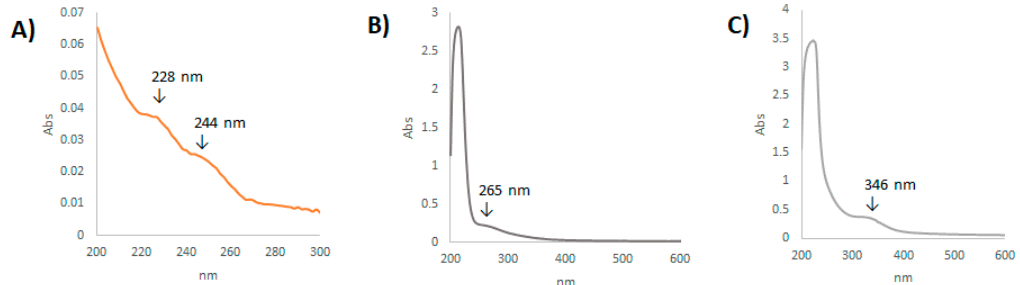
Figure 1. ( A ) Representative Cd UV-Vis spectrum recorded in distilled water. The spectral region 200–300 nm was highlighted; ( B ) Representative Cd UV-Vis spectrum acquired in tank water; ( C ) Cd + TiO 2 -NPs UV-Vis spectrum recorded in the range 200–600 nm.